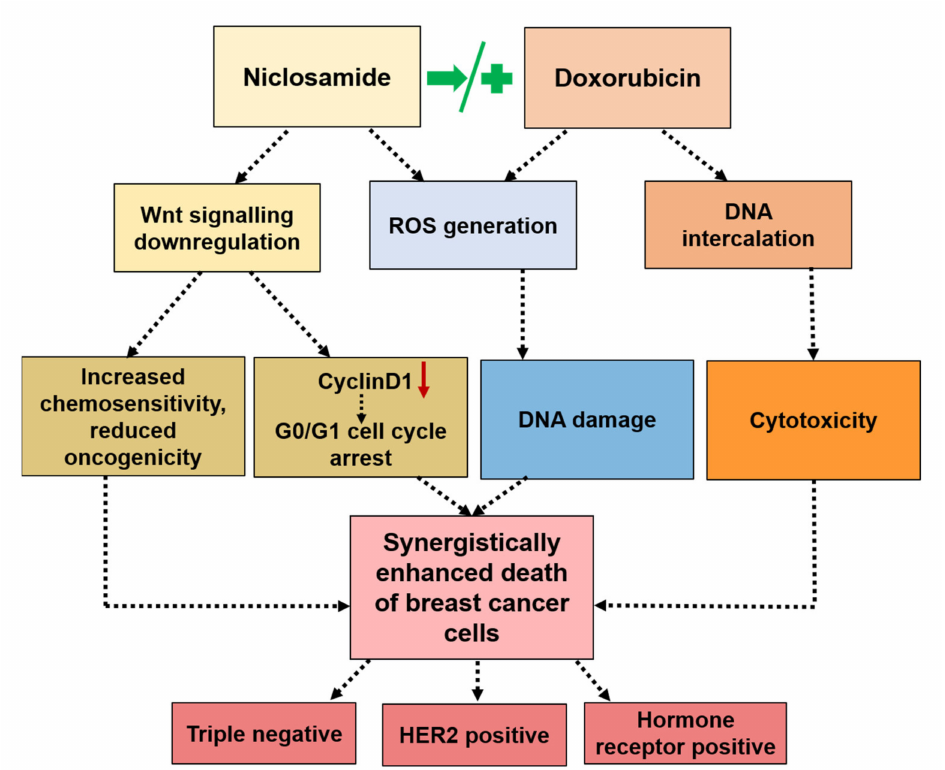
Figure 8. Mechanism of synergism between Nic and Dox in both sequential (Nic → Dox) and concurrent (Nic+Dox) treatment regimens.